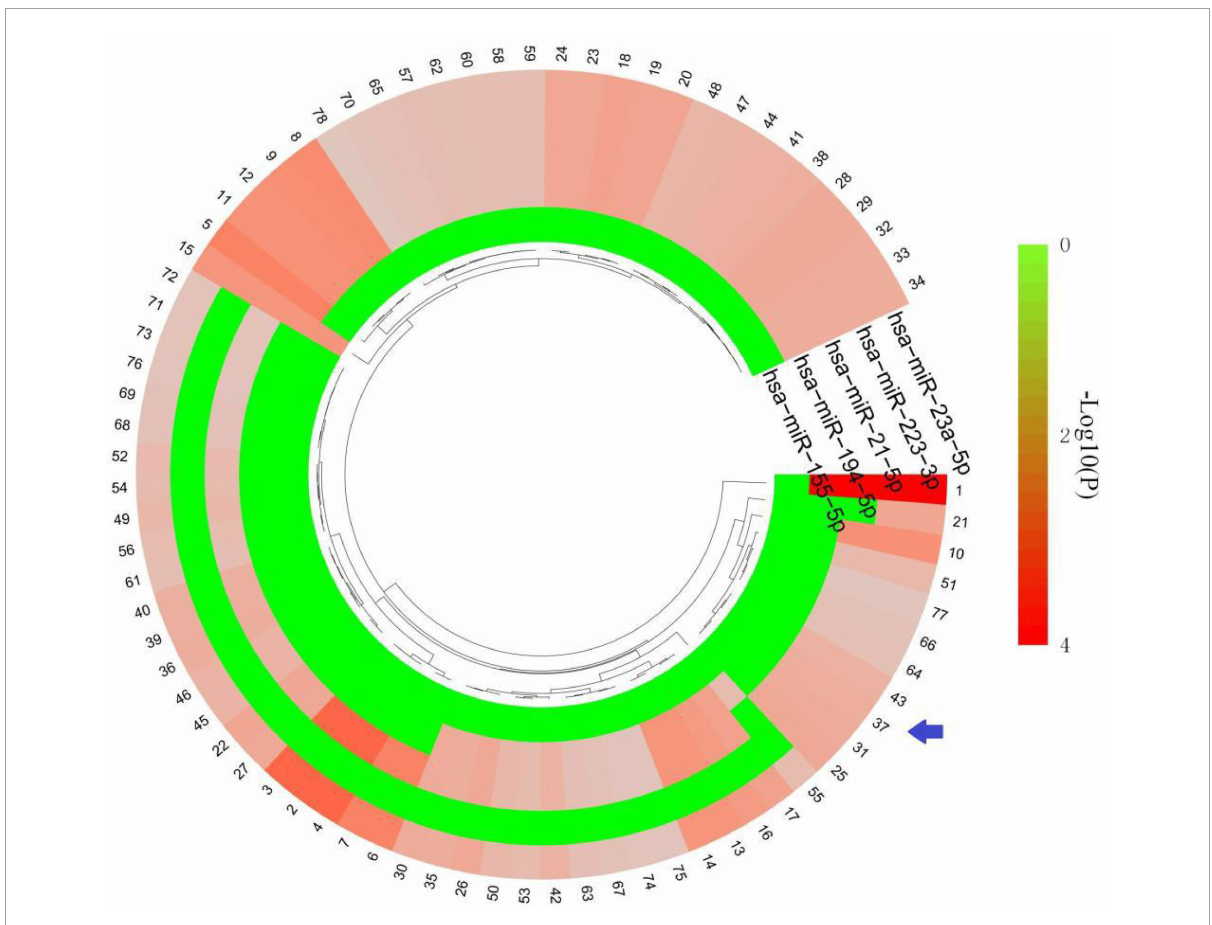
FIGURE7 KEGG terms of five common miRNAs. The arrow indicates interferon gamma signaling pathway. The detailed description of each term is in Supplementary Table 3 .